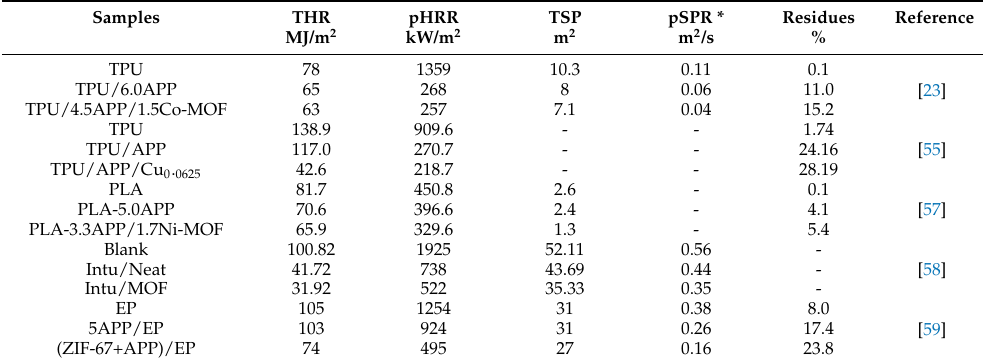
Table 1. Data comparison of MOF/APP as flame retardant and pure matrix.